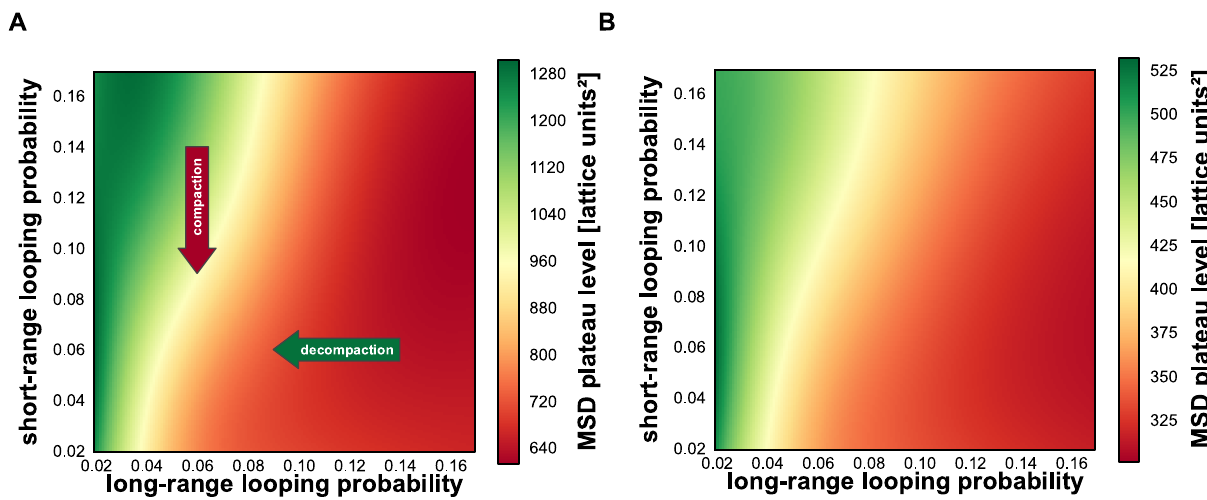
Figure 5. Heat plots showing how polymer compaction varies in the p short - p long parameter space. Polymer compaction is represented as MSD plateau level as shown in Figure 4. ( A ) adapted DL polymer, ( B ) domain-adapted DL polymer. The arrows in (A) show that decreasing the short-range looping probability (red arrow) results in compaction, while reducing the long-range looping probability (green arrow) leads to de- compaction. In the heat plot red marks compaction, green